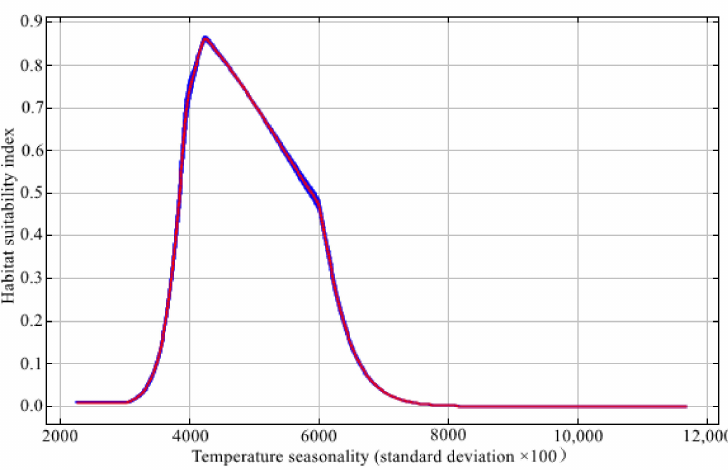
Figure 3. Response curve of C. amherstiae to temperature